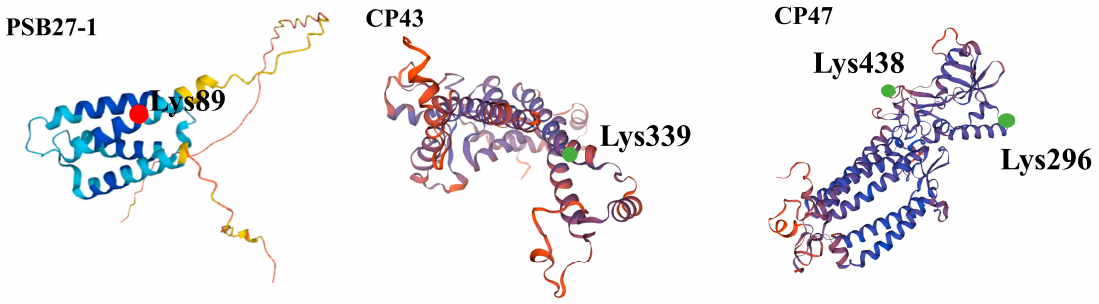
Figure 6. Three-dimensional homologous model of photosystem II acetylated proteins in response to UV-B stress. Red indicates an increase in acetylation level, while green indicates a decrease in acetylation level.